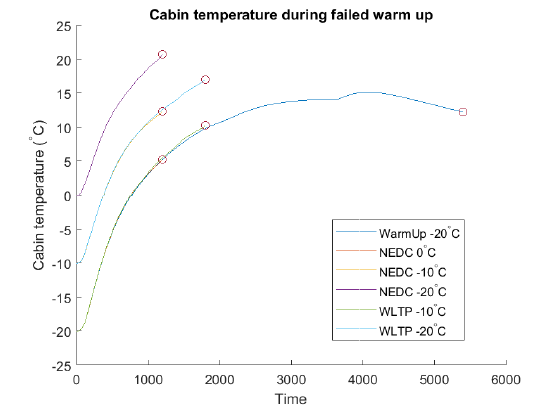
Figure 10. Here the cabin temperatures are shown for the best performing operational mode in scenarios where all modes failed to meet the target cabin temperature of 22 ◦